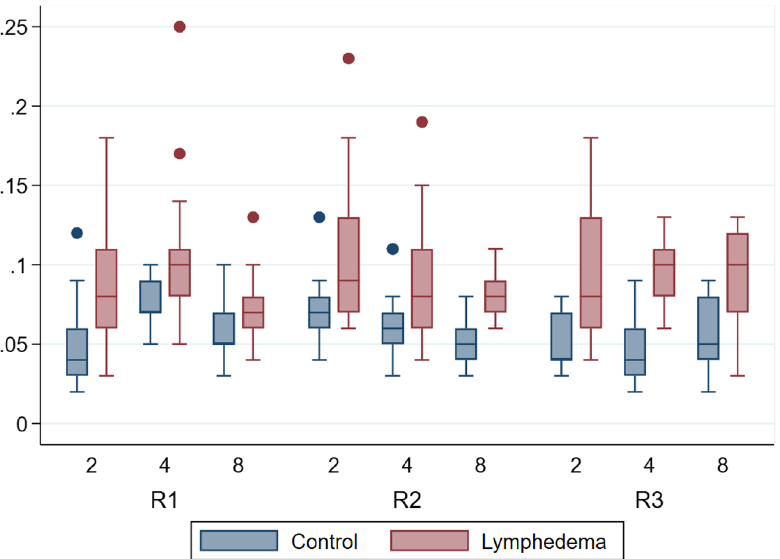
Figure 2. Descriptive boxplot showing plethysmometer by rater, week and group. The y-axis is in milliliters [mL]. The x-axis is weeks. R1 rater 1, R2 rater 2, R3 rater 3.